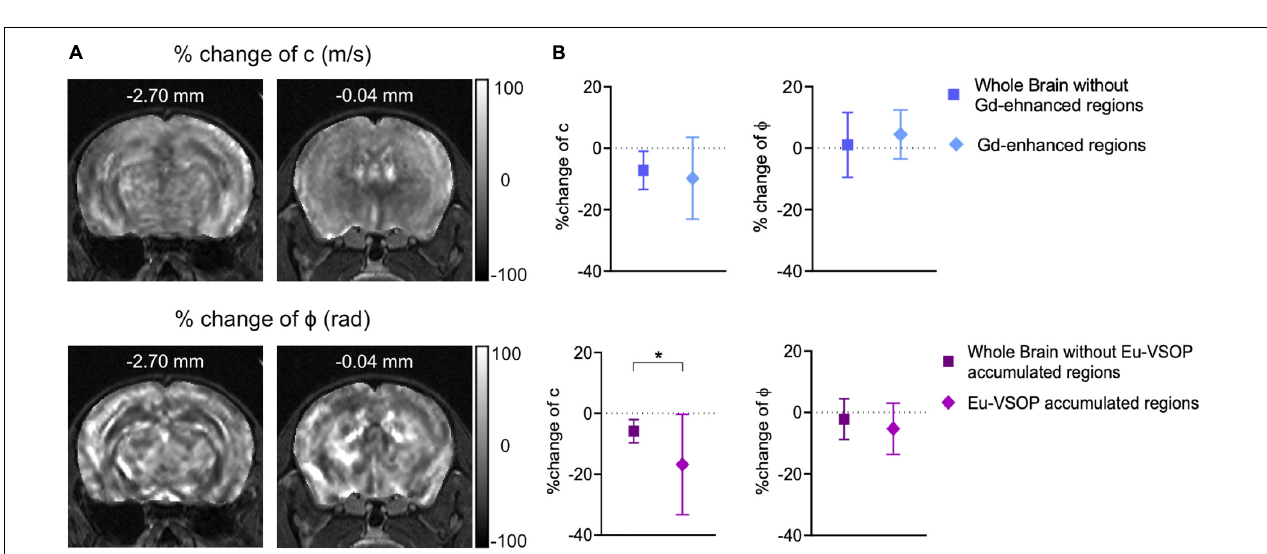
FIGURE 6 | Brain mechanical properties of areas accumulating Eu-VSOPs during EAE. (A) Exemplary image of a mask comprising Eu-VSOP accumulation overlaid on T2*-weighted image prior (left) and post Eu-VSOP (right) injection. (B) Shear wave speed map (c in m/s) and loss angle map ( φ in rad). (C) There is a significant reduction in stiffness in sites with Eu-VSOP accumulation compared to non-hypointense areas ( p = 0.0235, paired t -test). Fluidity of brain tissue in these areas, marked by φ , is not affected ( p = 0.1168, paired t -test). n = 8, mean, min/max; * < 0.05. Of note, ventricles are excluded from our analysis since MRE cannot be performed in fluid compartments.